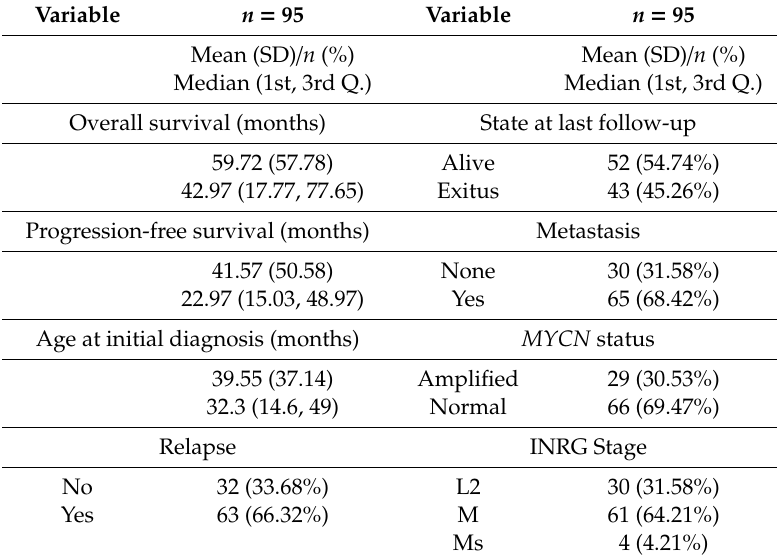
Table 1. Descriptive characteristics of the study